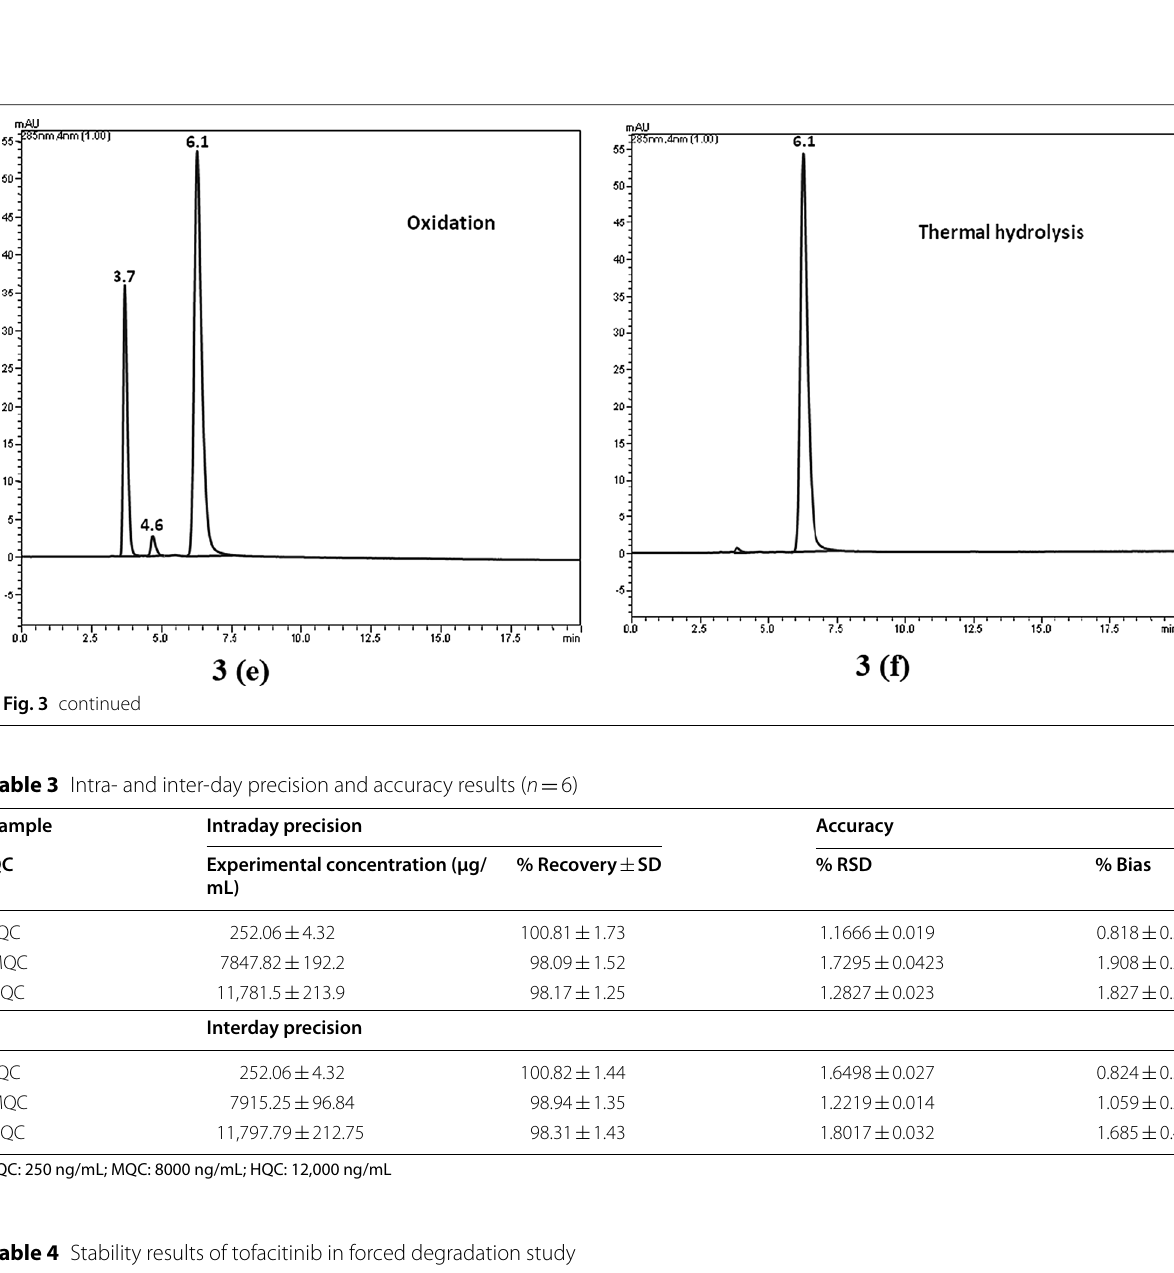
Table 4 Stability results of tofacitinib in forced degradation study Study